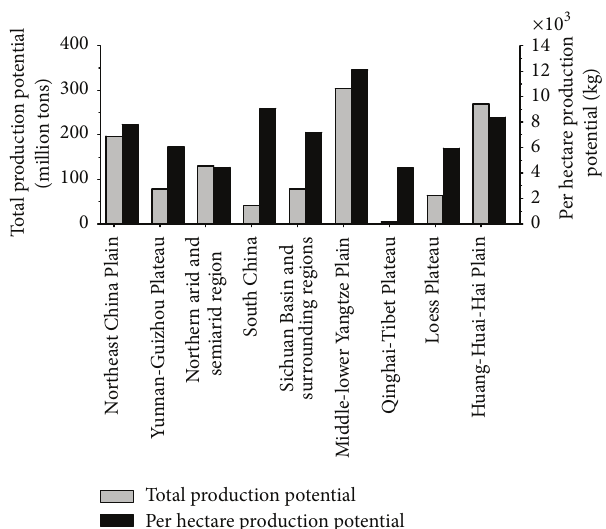
Figure 4: Production potential of various regions in 2010.